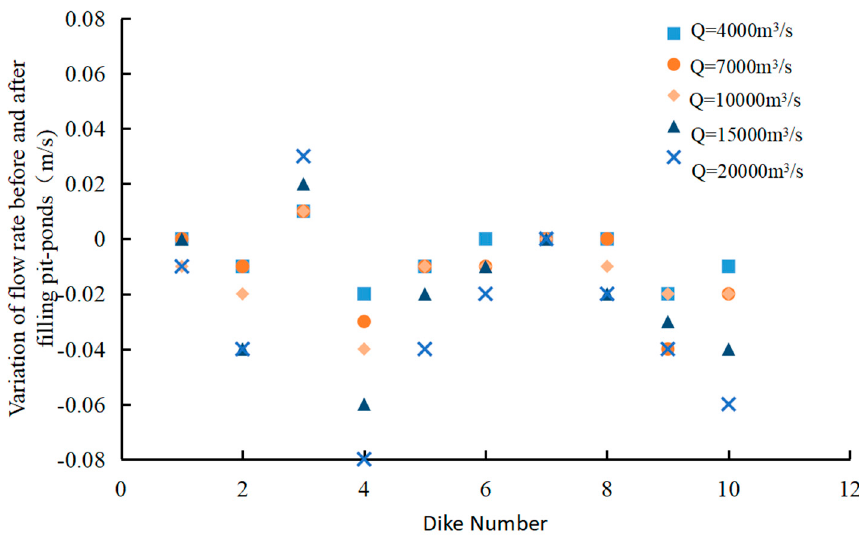
Figure 8. Variation of the velocity around the spur dike.